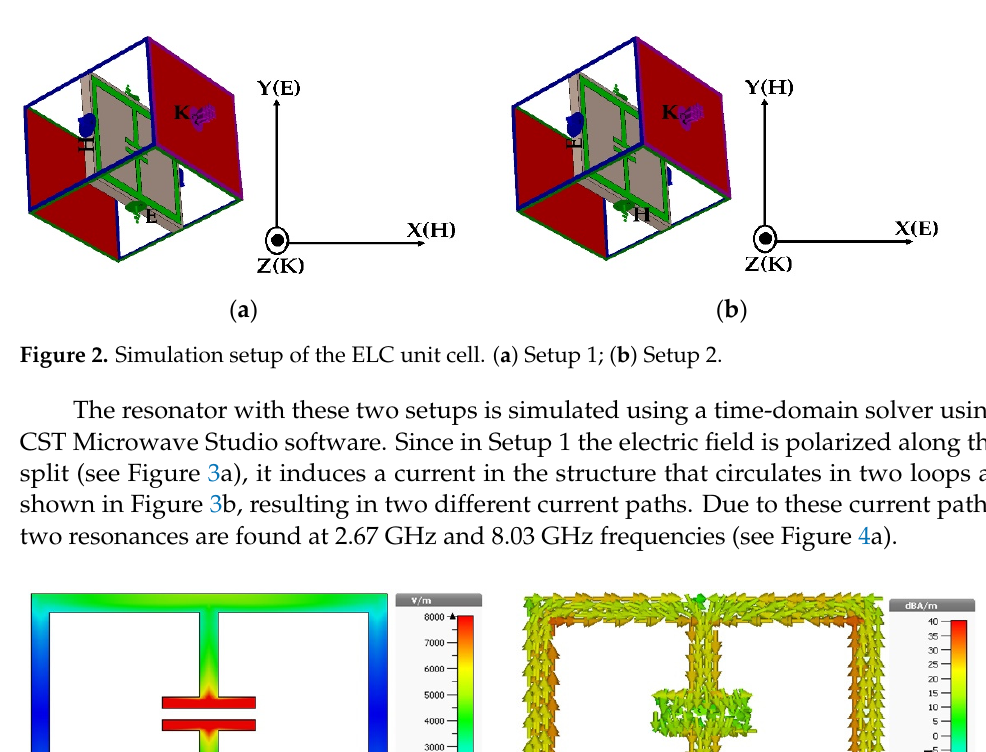
Figure 3. Distribution of ( a ) electric field and ( b ) surface current at 2.67 GHz for Setup 1.